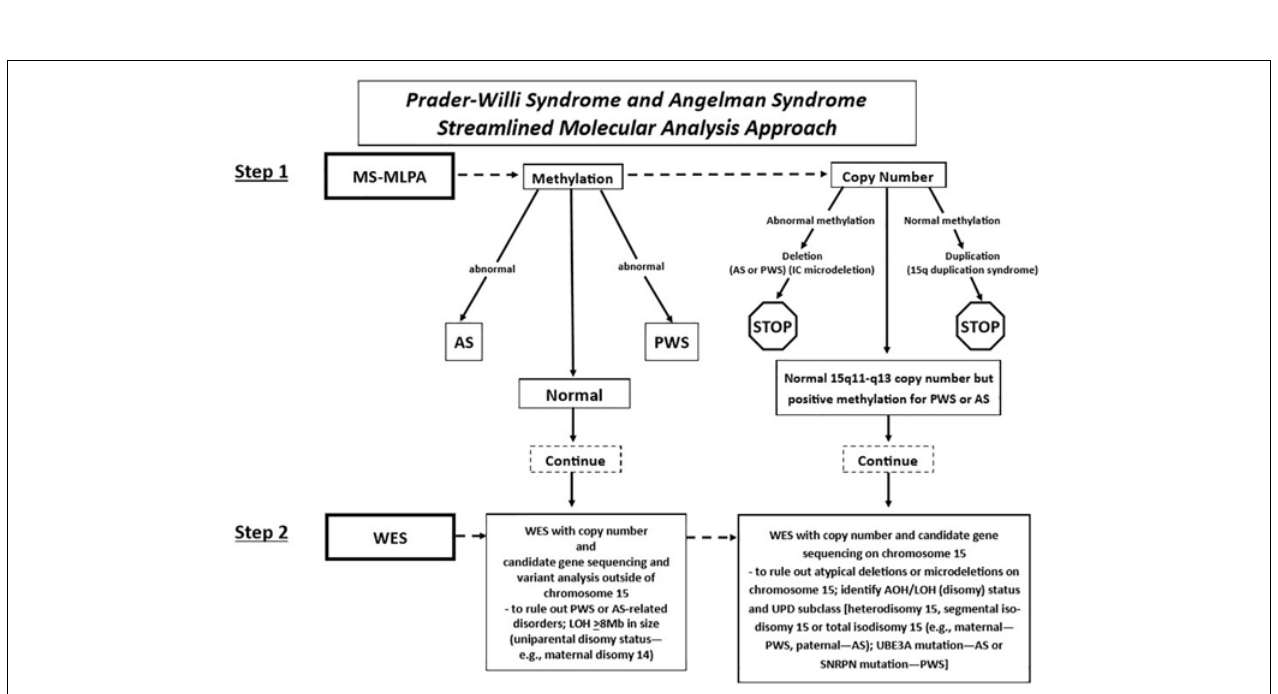
FIGURE 2 | Prader–Willi syndrome and Angelman syndrome molecular analysis workflow. The approach begins with methylation-sensitive MLPA (MS-MLPA) to determine the methylation status and copy number of the 15q11-q13 region (step 1). Based on the results of step 1, proceed to step 2, with whole-exome sequencing (WES) as illustrated in the flowchart for the determination of copy number status, sequencing of genes on chromosome 15 and elsewhere with the determination of AOH and/or LOH. UPD , uniparental disomy; PWS , Prader–Willi syndrome; AS , Angelman syndrome; AOH , absence of heterozygosity; IC , chromosome 15q11 imprinting center; LOH , loss of